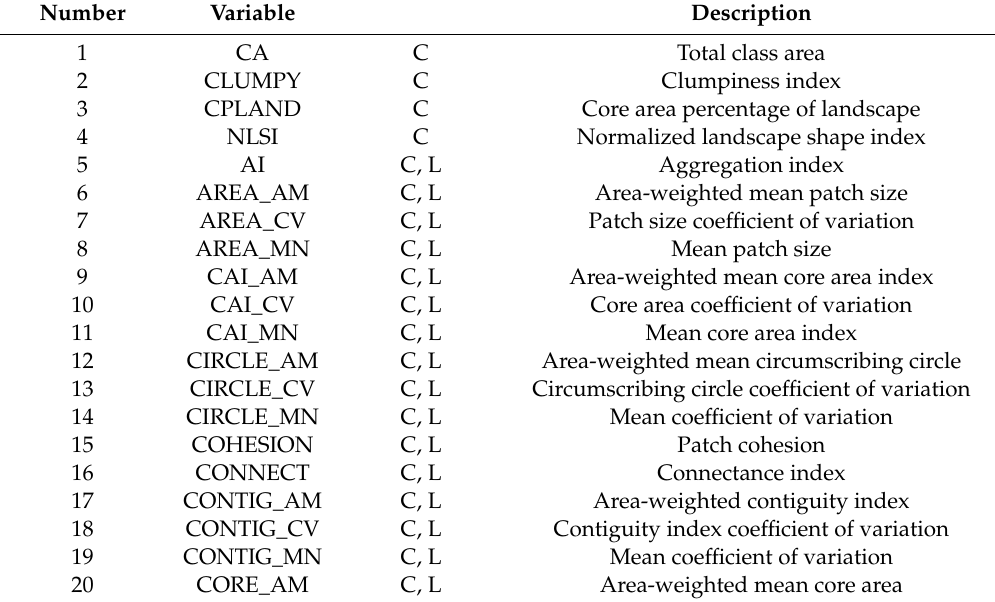
Table A1. List of 56 metrics in class level (C) and 63 metrics in landscape level